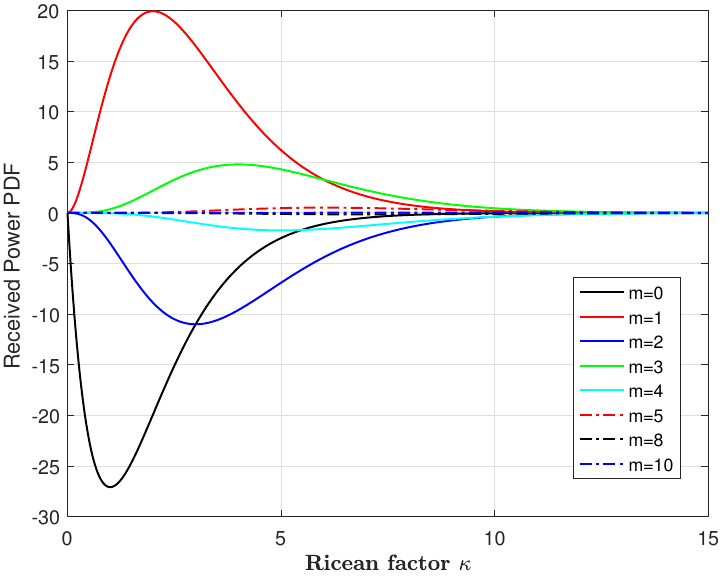
Figure 3. Convergence of the infinite series with values of Ricean